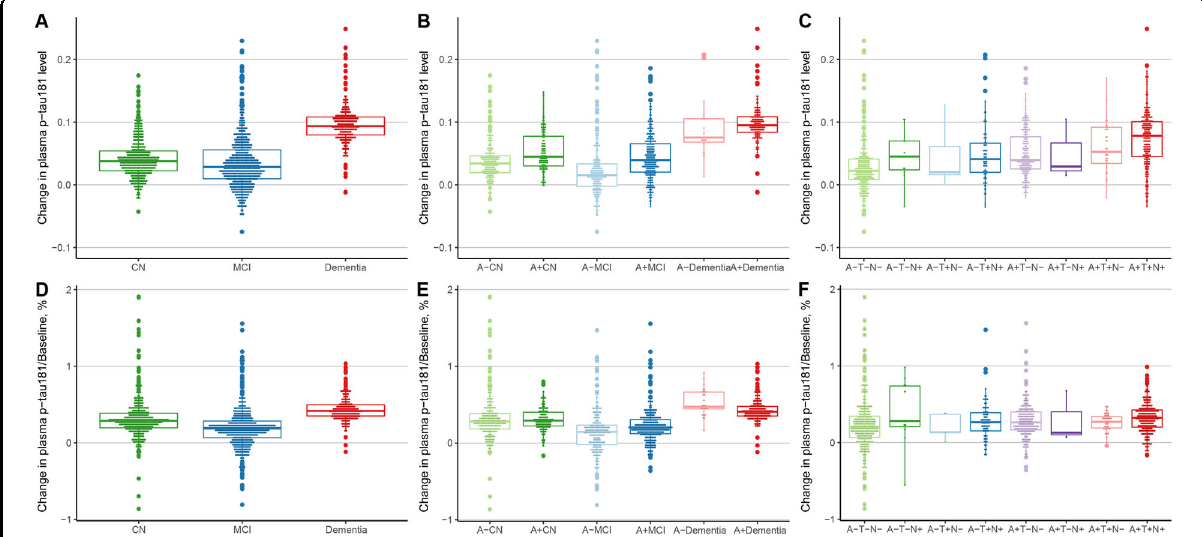
Fig. 2 Distribution of participant-speci fi c plasma p-tau181 slope. Participant-speci fi c plasma p-tau181 change rate by diagnosis ( A ), by diagnosis and A β status ( B ), and by ATN classi fi cation ( C ); Variability of participant-speci fi c plasma p-tau181 change rate by diagnosis ( D ), by diagnosis and A β status ( E ), and by ATN classi fi cation ( F ). Abbreviation: A β β -amyloid; A amyloid; T tau pathology; N neurodegeneration; p-tau phosphorylated tau; CN cognitive normal; MCI mild cognitive